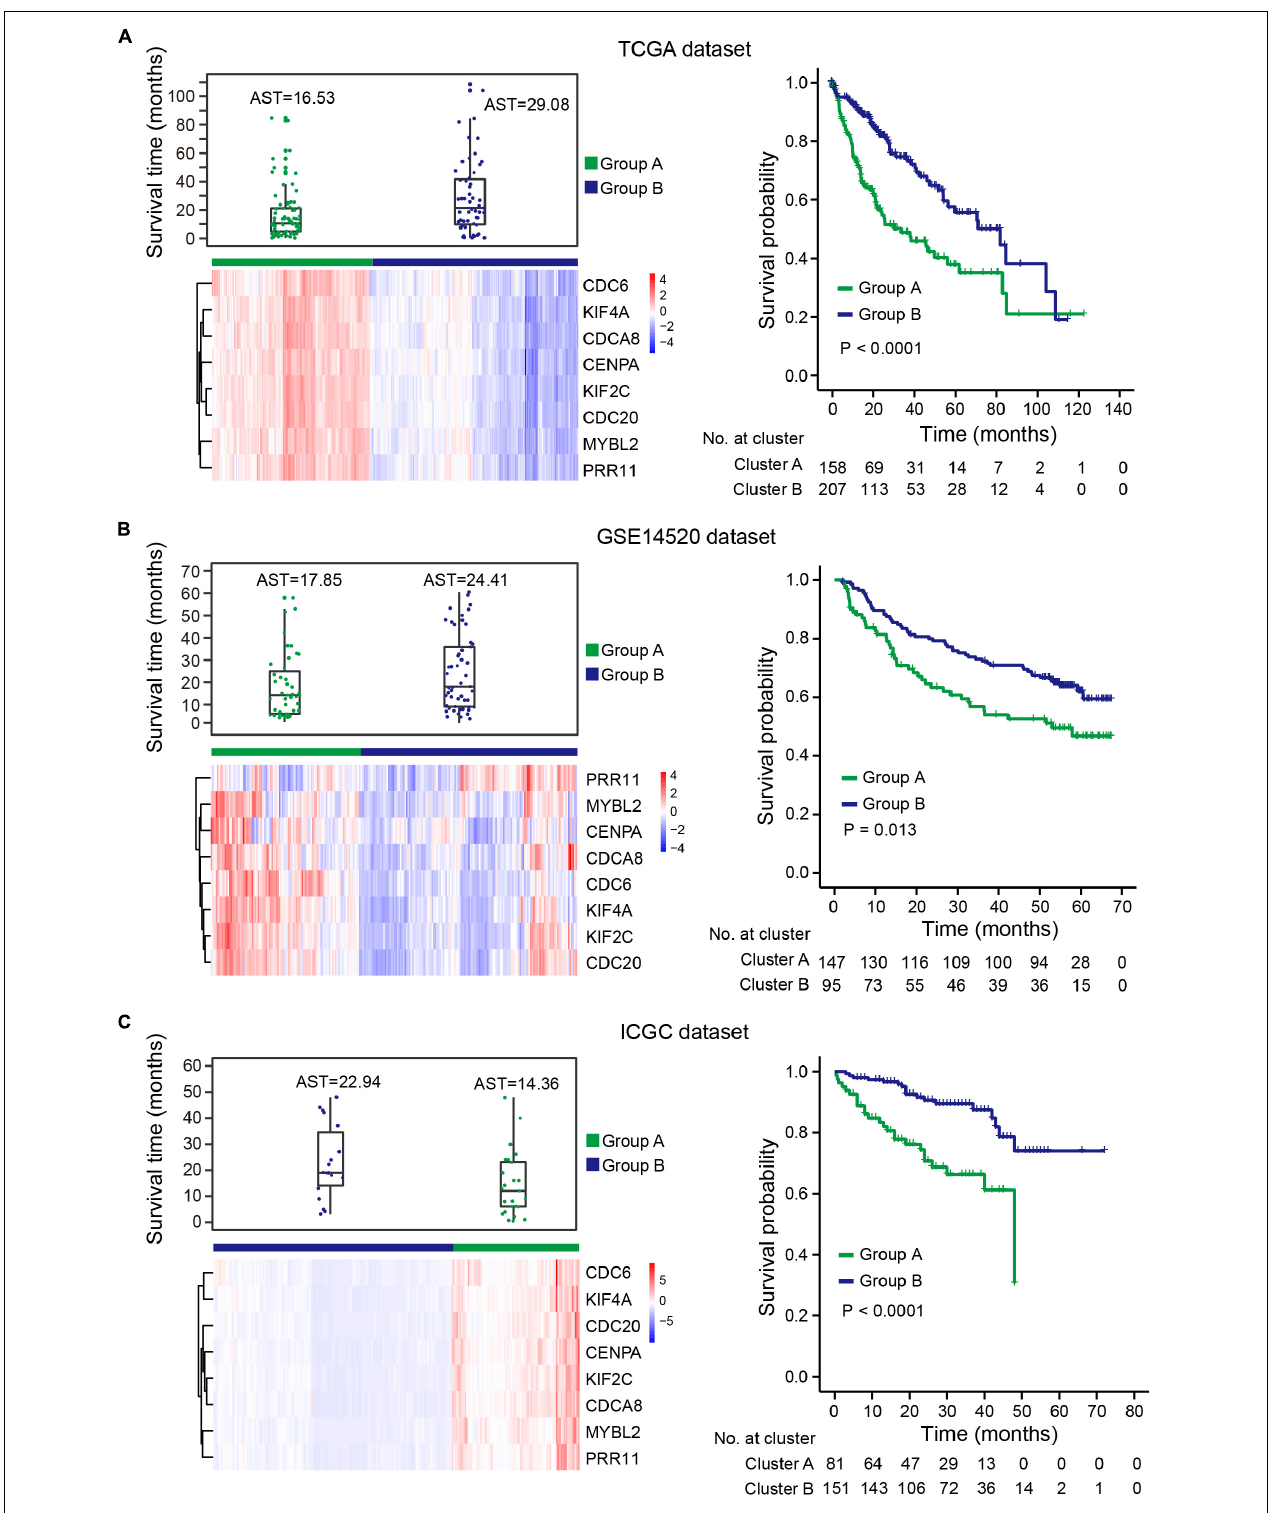
FIGURE 7 | HCCs grouped based on the expression of eight genes. (A) TCGA dataset, (B) GSE14520 dataset, (C) ICGC dataset. Upper left panel: survival time distribution of HCC patients with deceased status in group A (green) and group B (blue). Lower left panel: unsupervised hierarchical clustering of eight genes for HCC patients, patients were divided into two groups based on the expression of the eight genes. Right panel: KM survival analysis for HCC patients in the two groups. Group B had a better prognosis and OS than group A. AST: average survival time.